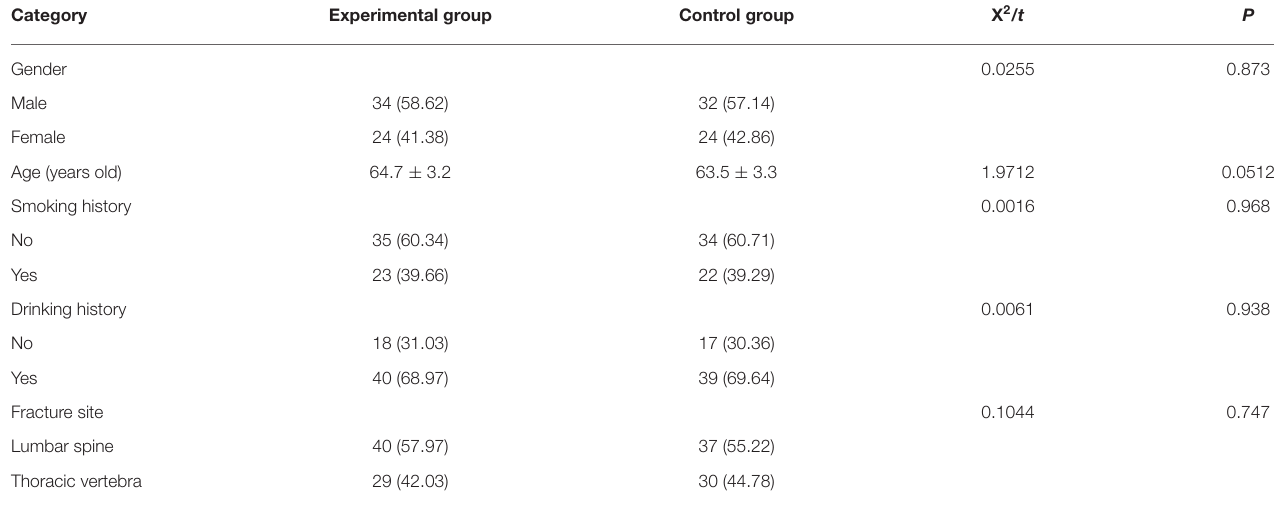
TABLE 1 | Comparison of general data of two groups of patients.